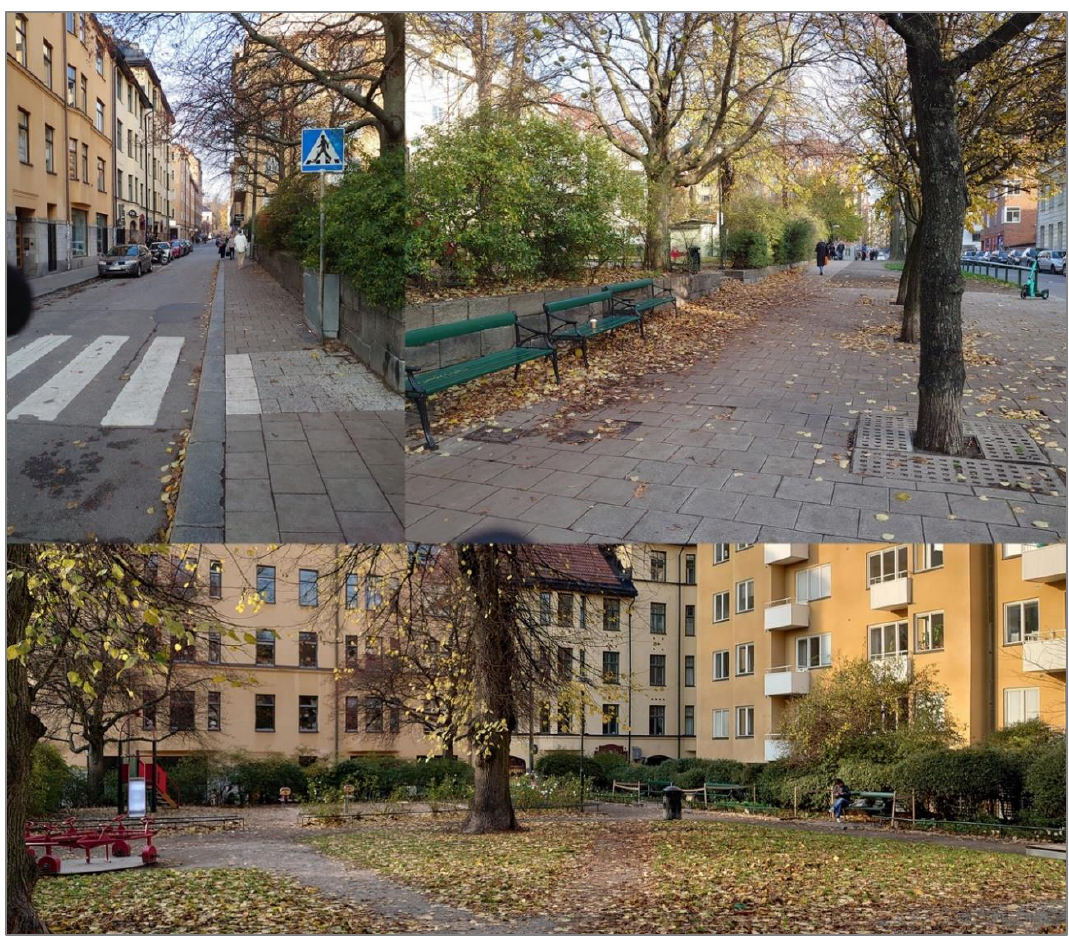
Figure 7 St. Axel Landquist’s Park. A view of one side of the park and height differences at the entry. October 30, 2021. Photographs by the